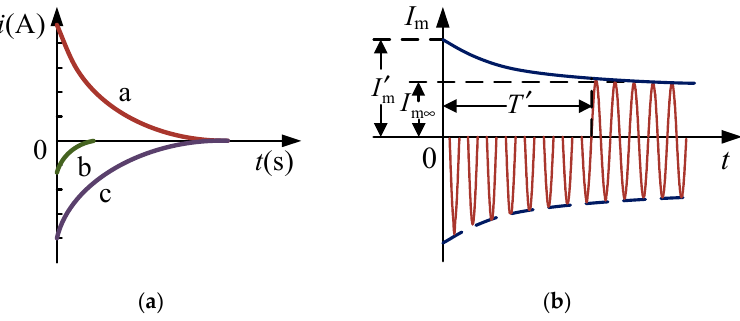
Figure 6. Decomposing of short-circuit current waveforms: ( a ) DC component; ( b ) AC component. Through multiple tests of photovoltaic inverter ES-5TLT, inductance L c and resistance R c , calculated by Equation (7), are 0.149 pu and 0.069 pu respectively, namely | Z c | = 0.164 pu. Terminal voltage of photovoltaic inverter, in Figure 5b, falls to 0.18 pu after fault, initial AC component value